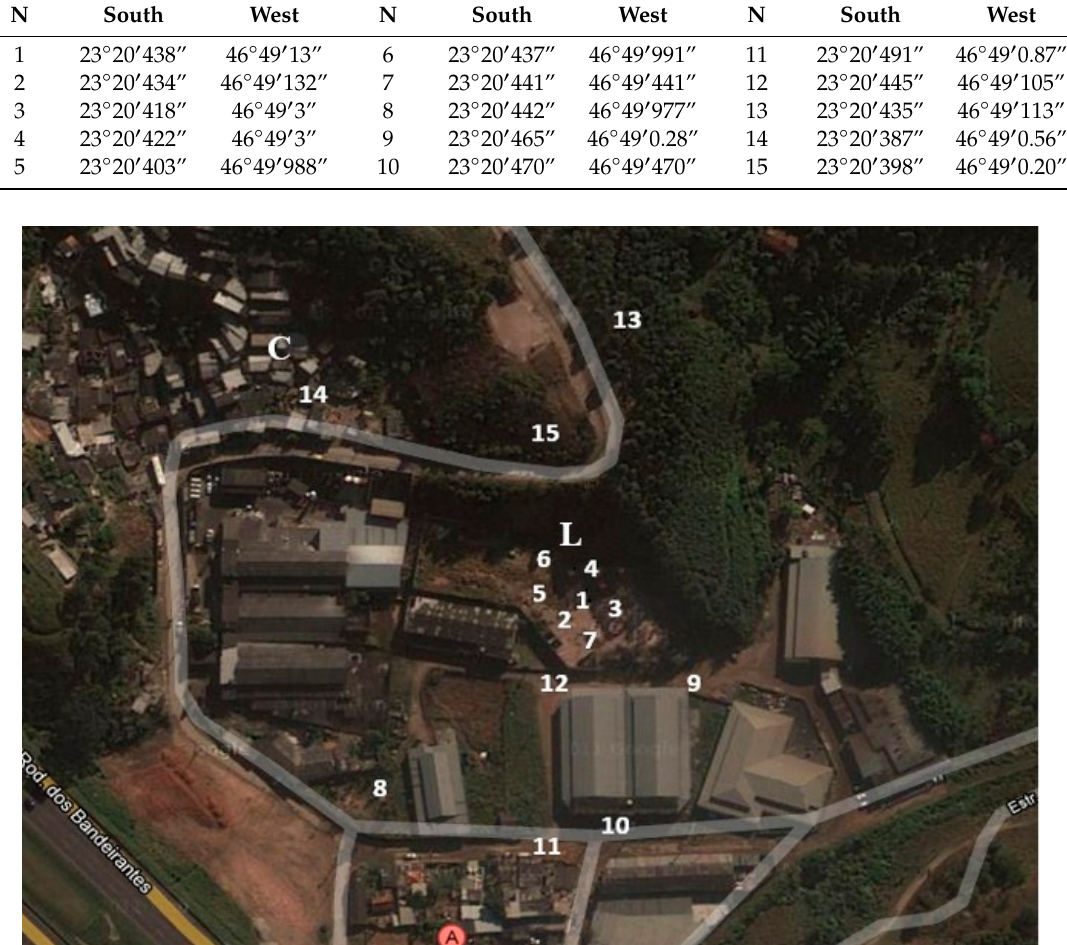
Table 2. Global positional system (GPS) coordinates of sampling at Caieiras landfill, SP, Brazil.